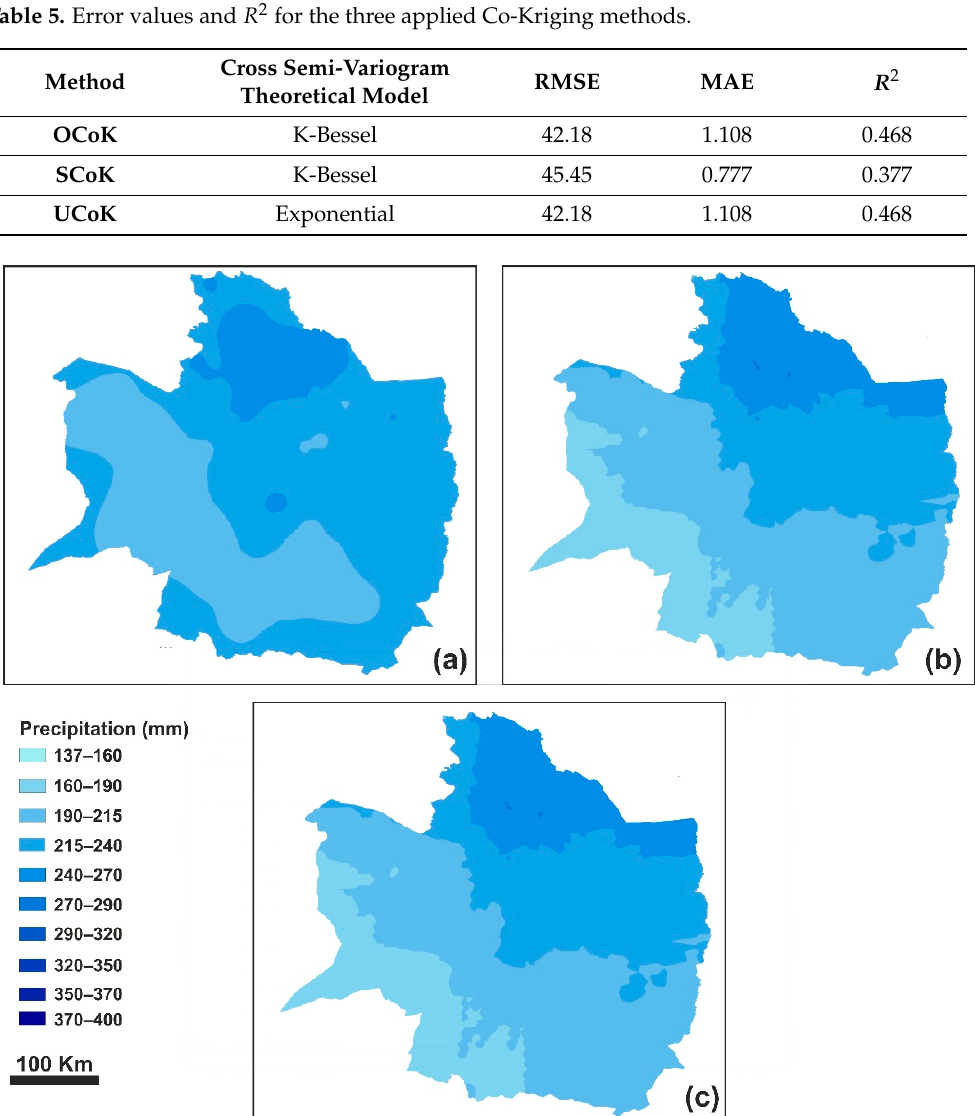
Figure 5. Interpolated annual precipitation maps based on the three Co-Kriging methods: ( a ) Simple, ( b ) Ordinary, ( c ) Universal.